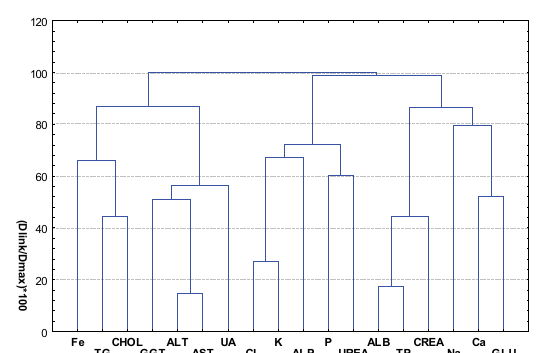
Figure 2. Hierarchical dendrogram of biochemical variables for male healthy individuals